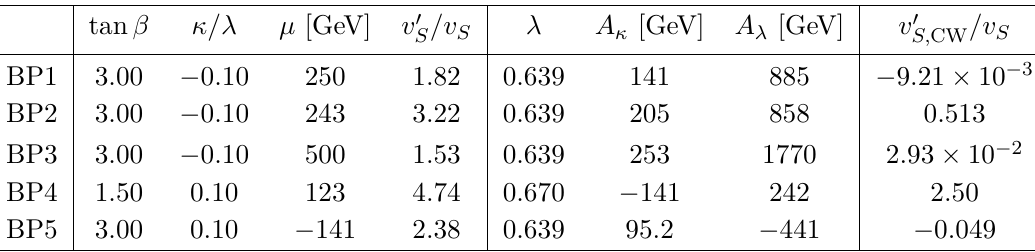
Table 1 . Parameters controlling the scalar potential for our benchmark points. The left-most block of parameters contains the input parameters for our CosmoTransitions calculation. The middle block contains derived parameters. In particular, we note that λ and A are fixed by the alignment λ conditions, see eqs. (2.19)–(2.21), and A is fixed by v 0 , see eq. (2.42). In the right-most column κ S we show the ratio v 0 /v S which is obtained from the effective potential after including radiative S, CW corrections, see eq. (3.4) and associated discussion.